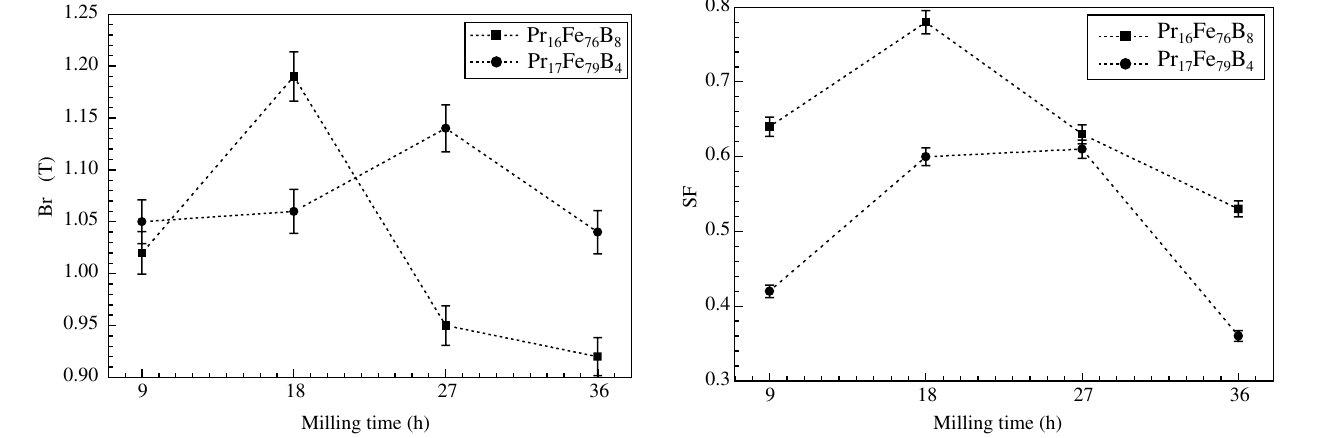
Figure 5. Squareness factor vs. of Pr a function of milling time.